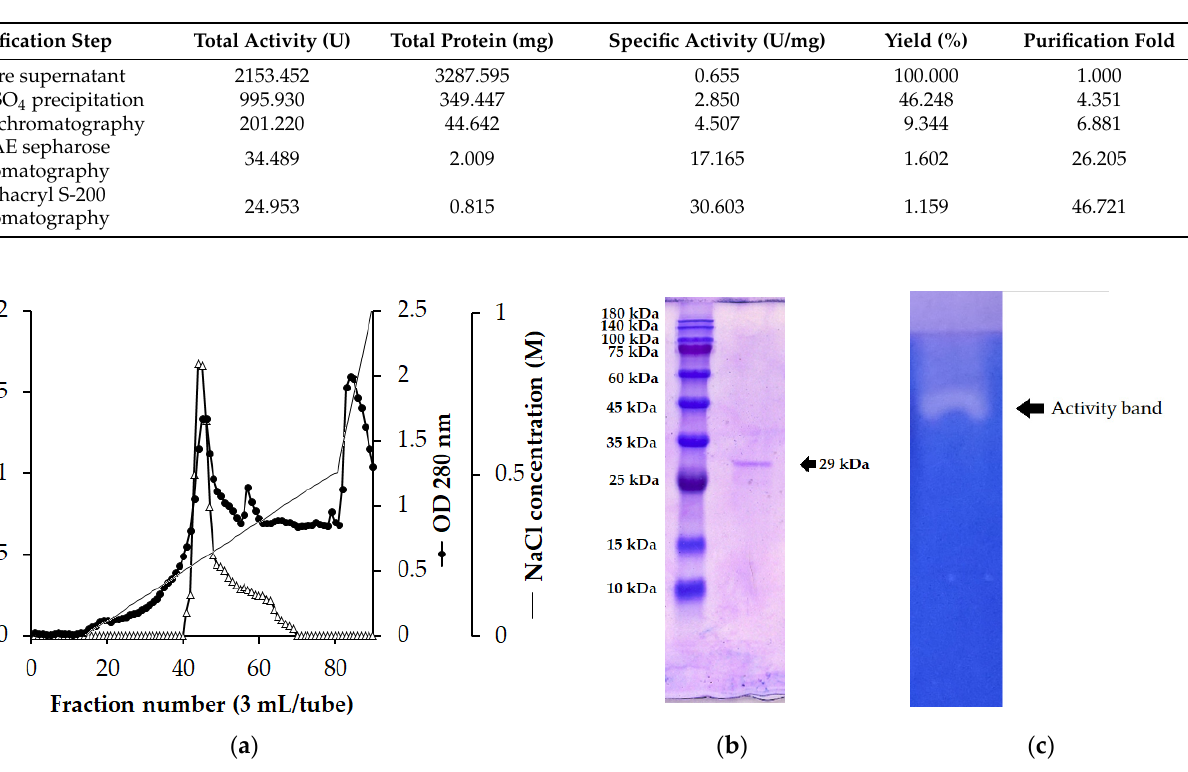
Figure 2. High Q chromatography profile of the crude enzyme ( a ) and SDS-PAGE profile ( b ) and in-gel activity ( c ) of purified P. elgii TKU051 protease.